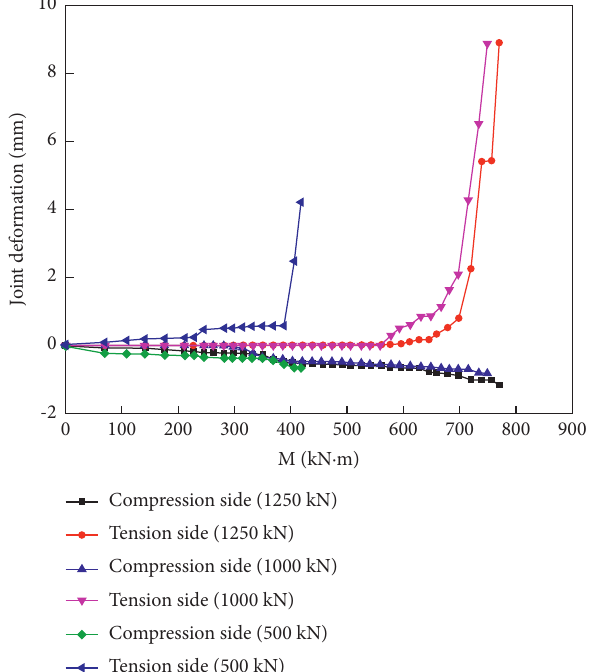
Figure 14: Deformation development of double-tenon joints with auxiliary pretightening device on the compression